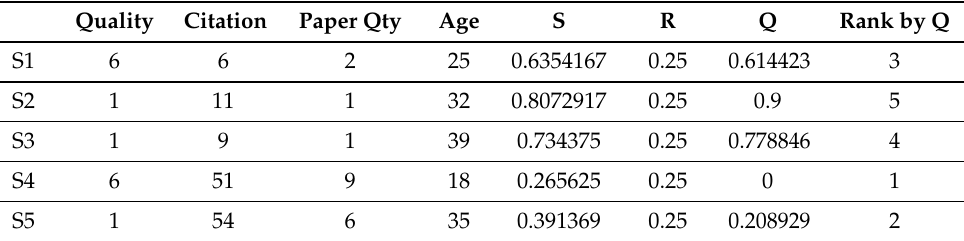
Table 1. Sample rank for five